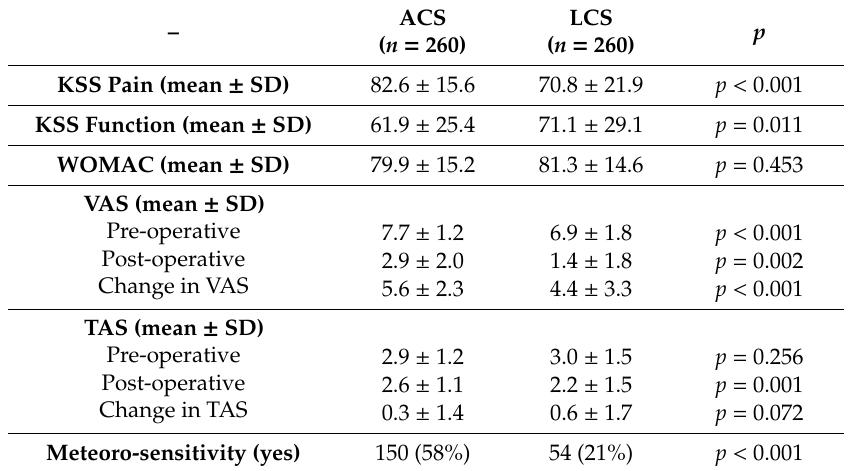
Table 2. Comparison of Meteoro-sensitivity and Clinical Outcome before (except KSS and WOMAC) and after mean final follow-up between ACS and LCS